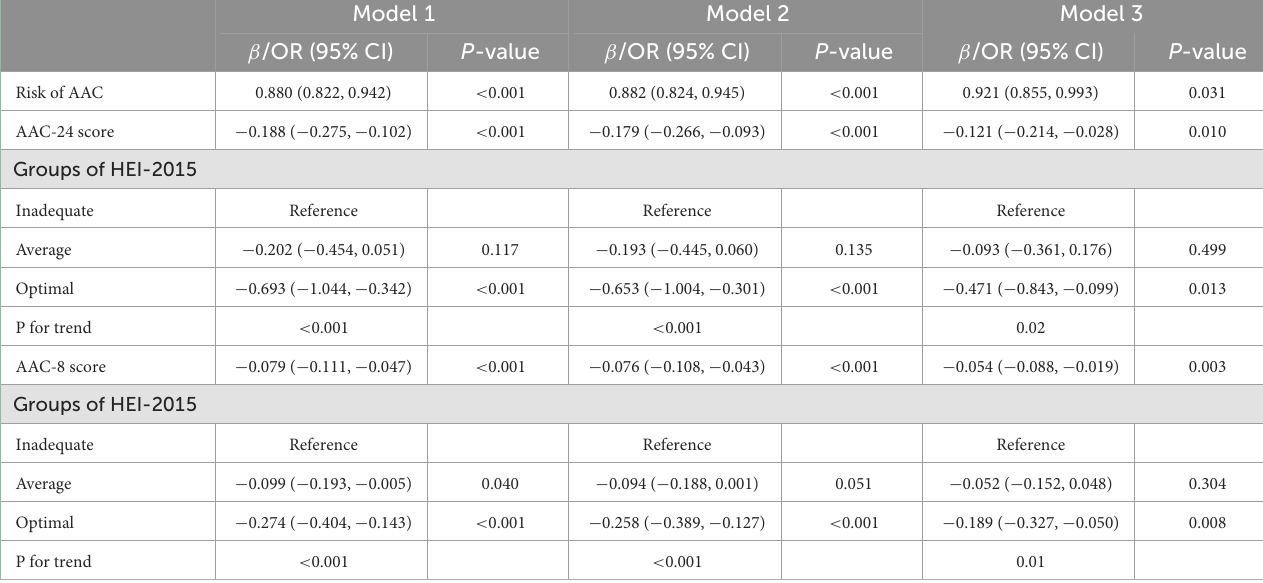
TABLE 2 Associations of 10-unit increments of HEI-2015 with AAC score and the risk of AAC.